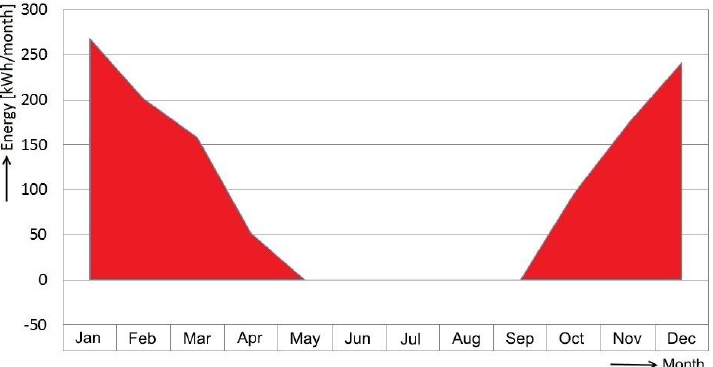
Figure 3. Heated office room.